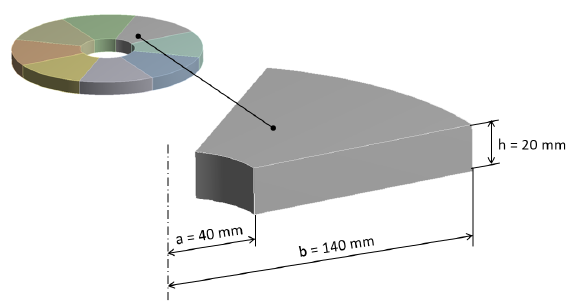
Fig. 1. Geometry and dimensions of the domain